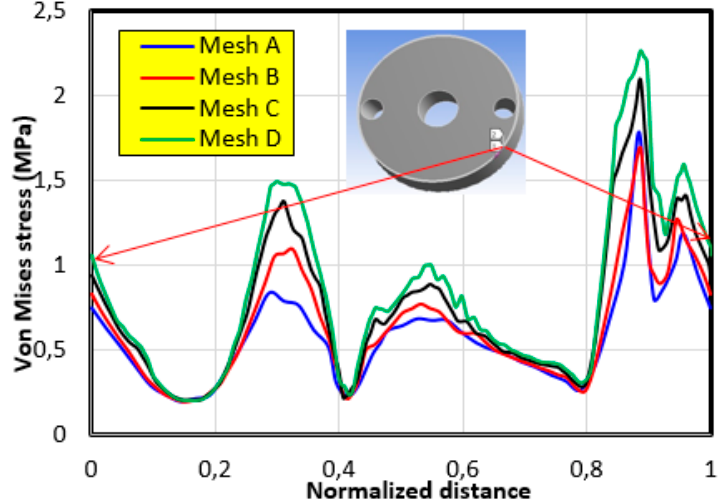
Figure 8. The evolution of the Von Mises stress along the peripheral contour of the bone graft for different meshes.